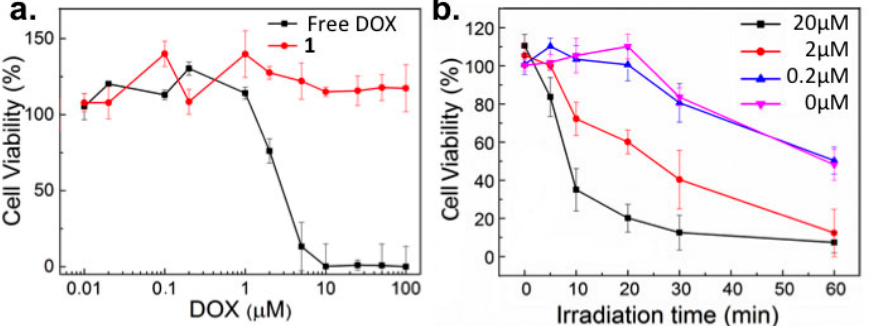
Figure 3. Viability of HeLa cells in vitro treated with doxorubicin pro-drug micelles. ( a ) Cell viability following incubation with varying concentrations (10 nM–100 µM) of free DOX ( black ) and 1 ( red ) in the absence of light; ( b ) Viability of HeLa cells in vitro treated with varying concentrations of 1 and irradiated (365 nm, 15–17 mW/cm 2 ) for up to 1h. Pink line corresponds to photoinduced cytotoxicity.